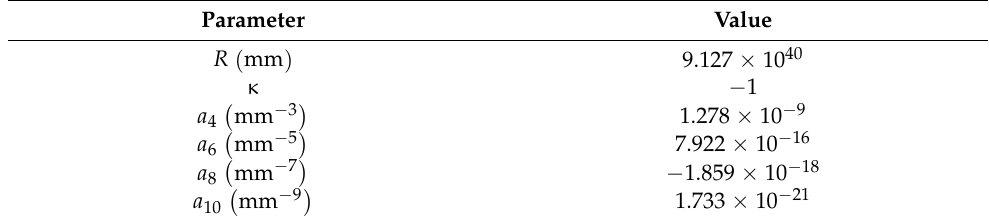
Figure 6. Design of the proposed thermo-invariant material measure for freeform surface TIMM-2 with application in industry.